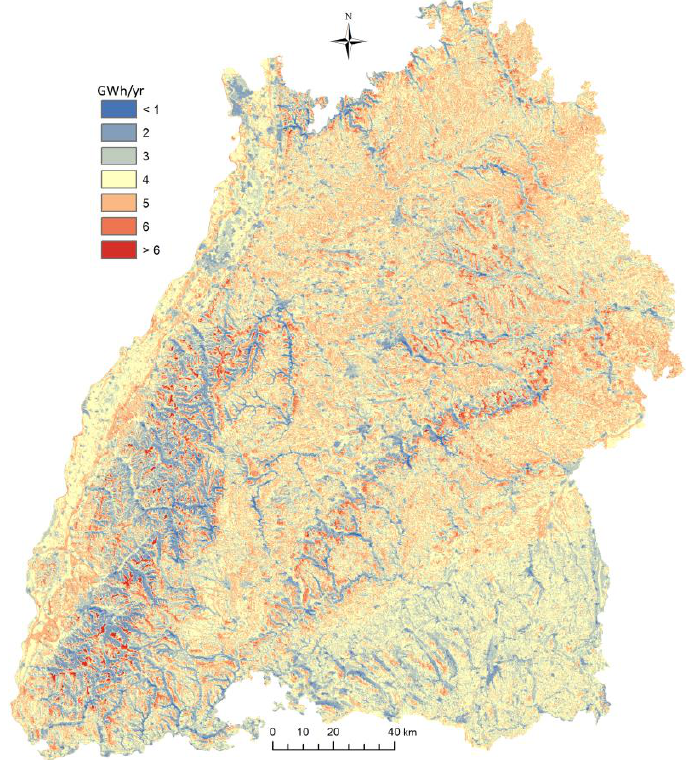
Figure 6. AEY mod in the study area. The legend values indicate highest class values.